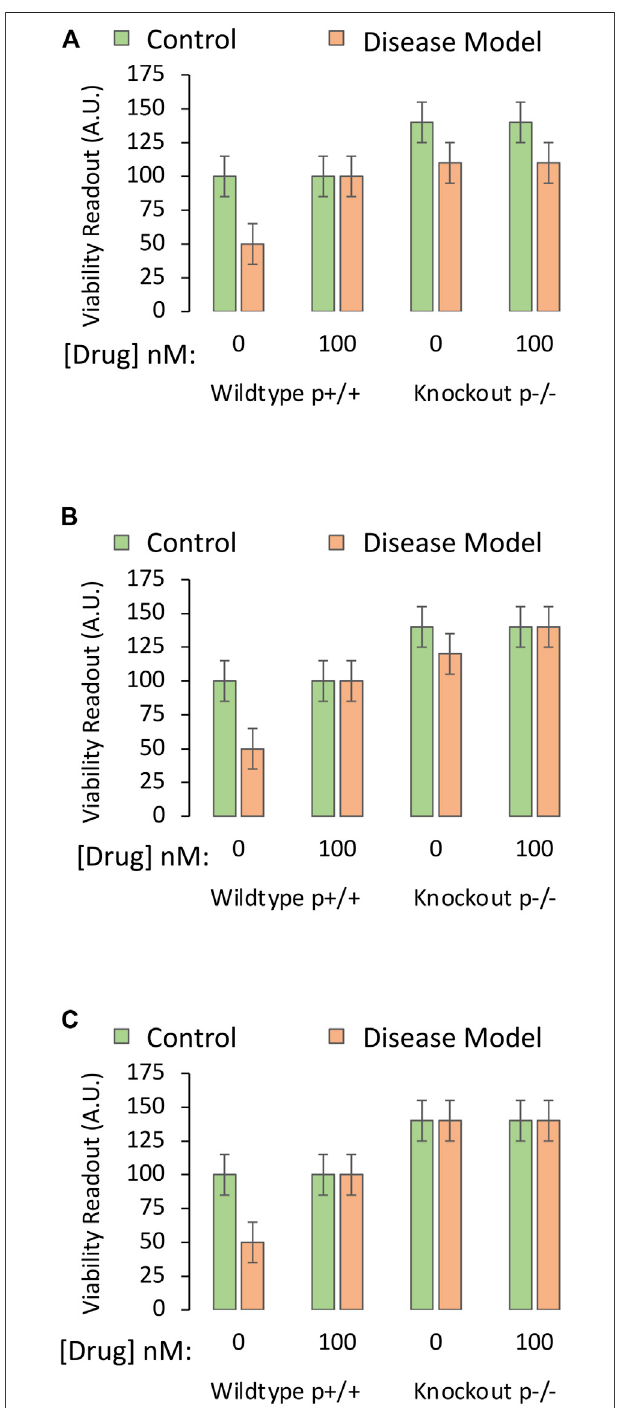
FIGURE 6 | Testing the mechanistic hypothesis by leveraging knockout of the gene encoding a protein that is downregulated by the drug. A speci fi c and sensitive cell culture-based viability assay is used to screen whether the drug candidate exerts its protective impact through suppression of the function of the pro-apoptotic protein. The Y axes re fl ect cellular viability levels (the dependent variable), and the X axes indicate two independent variables: